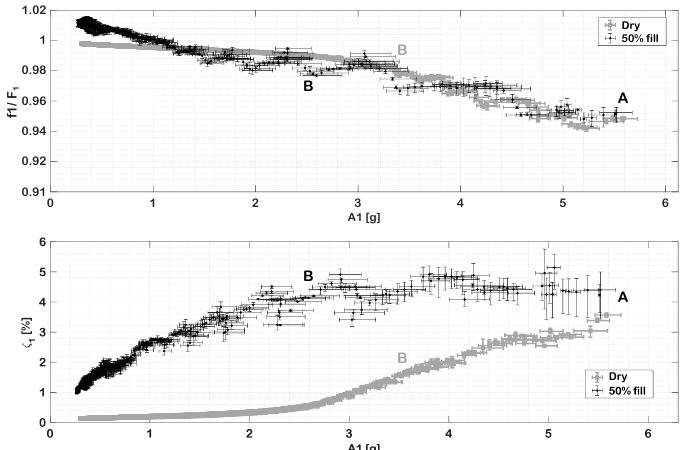
Figure 13. Component 1 frequencies and damping ratios vs. component 1 acceleration amplitude, 50% filling level and dynamically equivalent dry case. Error bars show the variability between test repetitions. The amplitude decays following the step release event at A